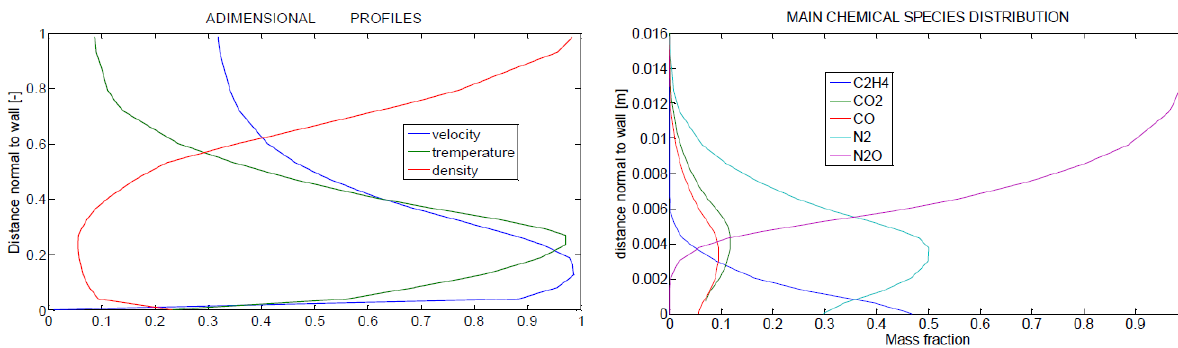
Figure 14. Plots from [92] showing marked peaks in radial profiles due to